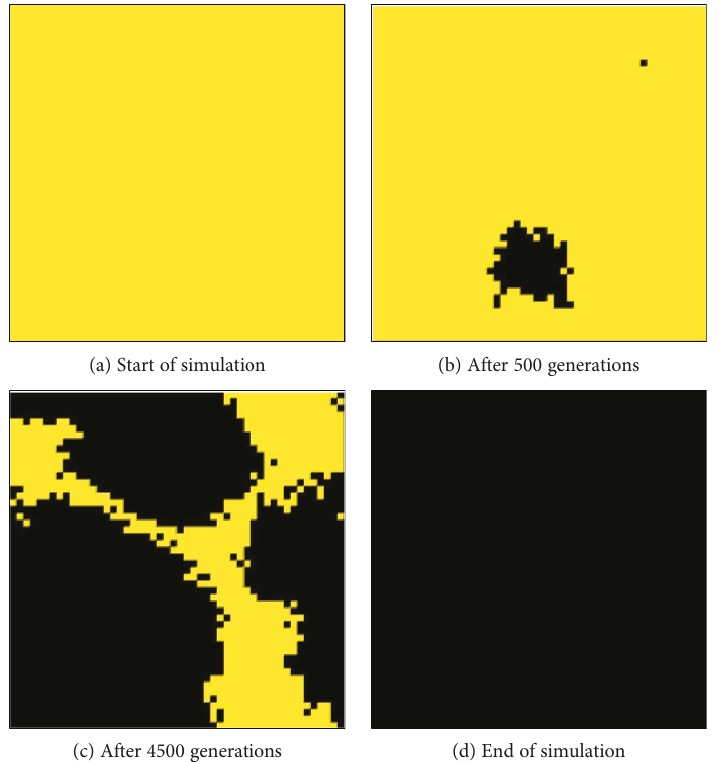
Figure 16: Illustration of a system where mutations of silent cooperator genes ( Y = S ) occur in a 50 × 50 system dominated by defector genes ( Y = D ). Silent genes get activated later at a random point of time t ′ to express the cooperative trait.